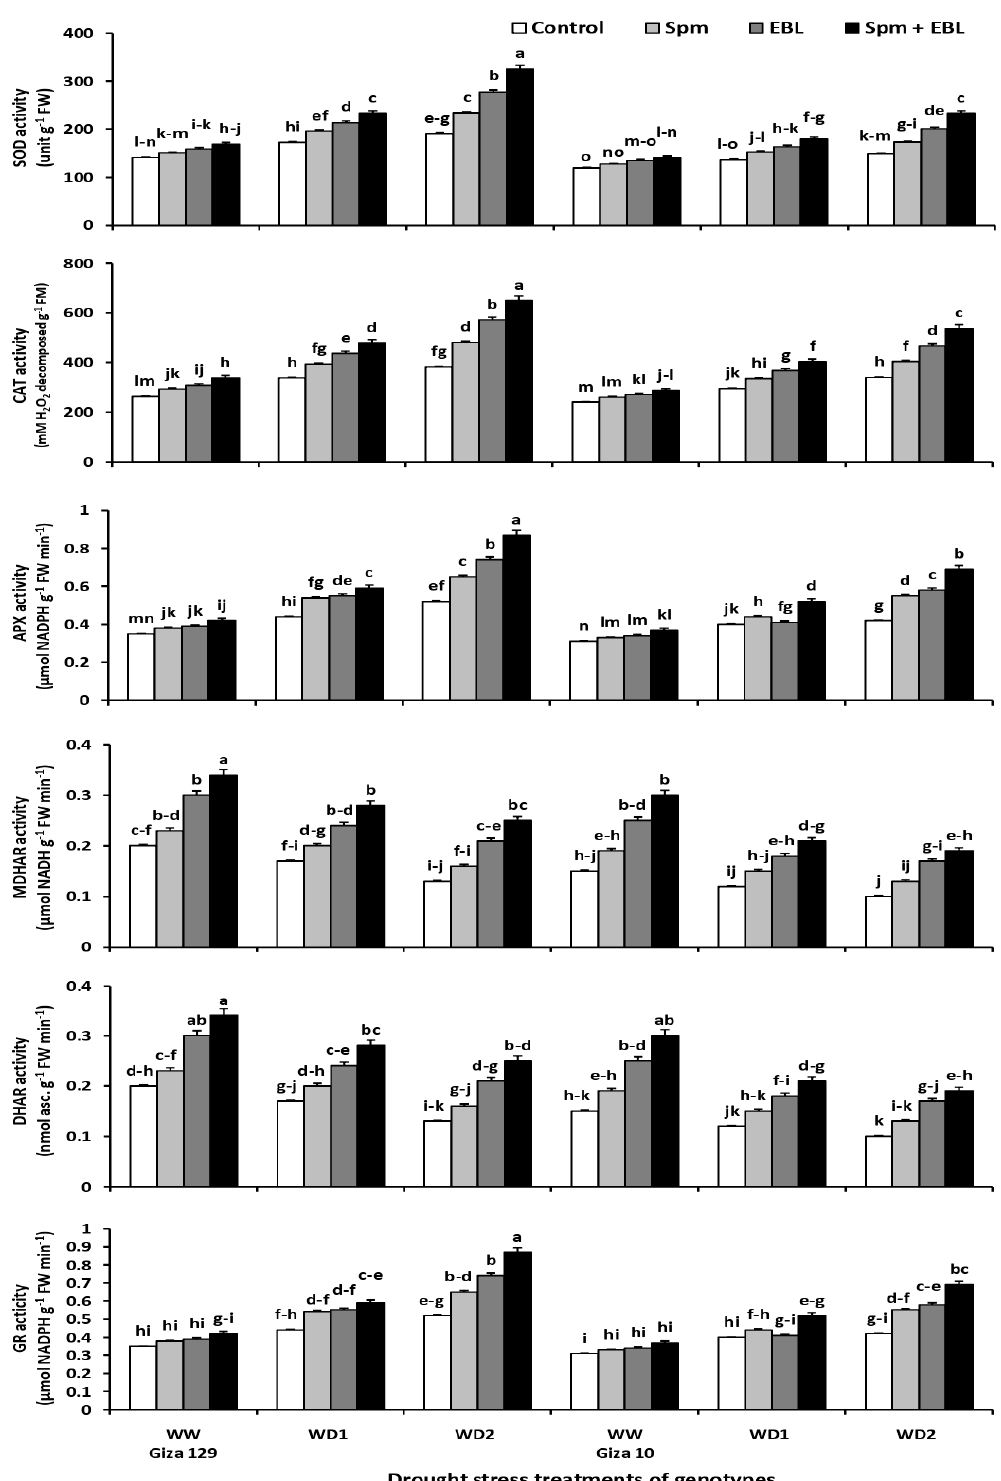
Figure 4. Influence of foliar application with distilled water (control), 25 mg L − 1 Spm, 0.1 mg L − 1 EBL, or 25 mg L − 1 Spm + 0.1 mg L − 1 EBL on the activity of superoxide dismutase (SOD), catalase (CAT), ascorbate peroxidase (APX), monodehydroascorbate reductase (MDHAR), dehydroascorbate reductase (DHAR), and glutathione reductase (GR) in leaves of maize plants of both genotypes—Giza 129 and Giza 10—exposed to drought stress treatments (control (100% field capacity (FC); WW) and water deficit (75% FC and 50% FC; WD1 and WD2)). Values are the mean ± SE (n = 6). Different letters indicate significant differences at p < 0.05 level according to LSD